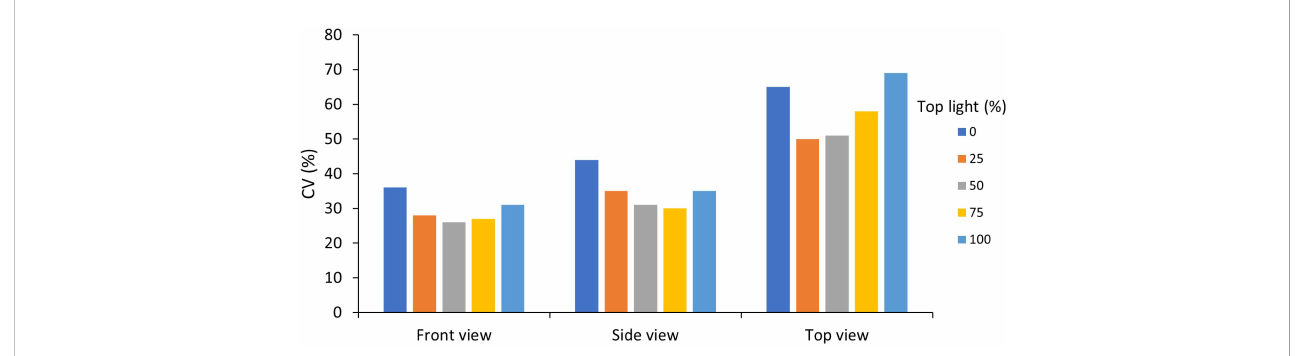
FIGURE 9 Effects of percentage top light (0, 25, 50, 75 or 100%) on the mean coef fi cient of variation (CV) within voxels of absorbed canopy PPFD for the front, side and top view of the canopy. Top light percentage was 0, 25, 50, 75 and 100%, with respectively, 100, 75, 50, 25 and 0% intra-canopy light. Each voxel had the dimensions of 7.5 cm width and length and a depth reaching 6 plants in each row of a double row stretching across four double